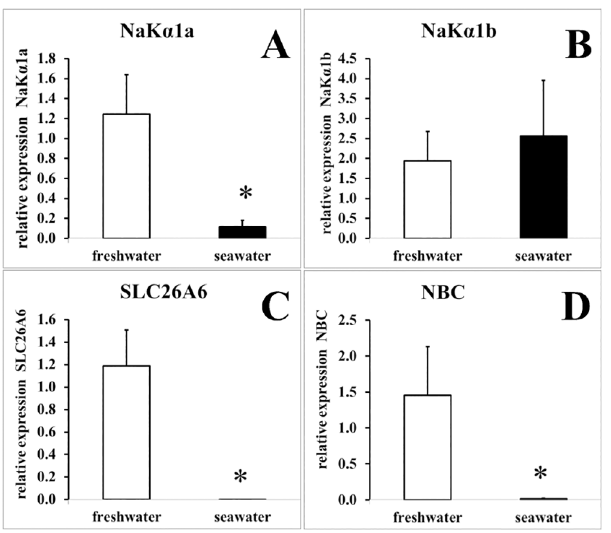
Fig 4. Quantitative real-time PCR of 4 genes in freshwater and seawater ionocytes. Values represent means ± s.e.m. of four fishes. * , significantly different from the corresponding values in freshwater at P < 0.05, Mann-Whitney